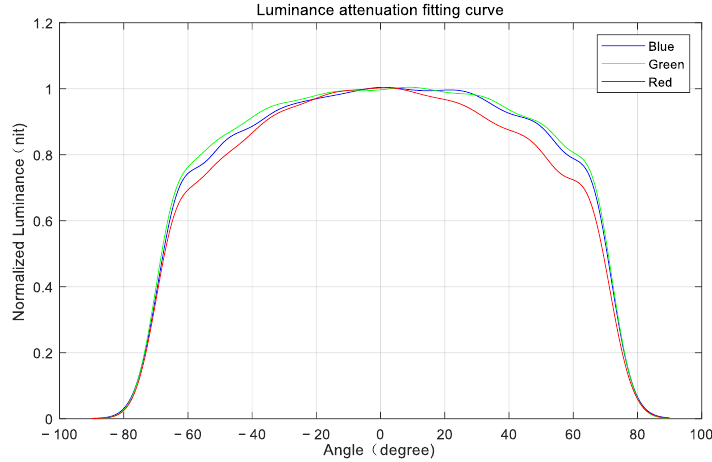
Figure 4. Luminance attenuation fitting curve of the three primary colors.